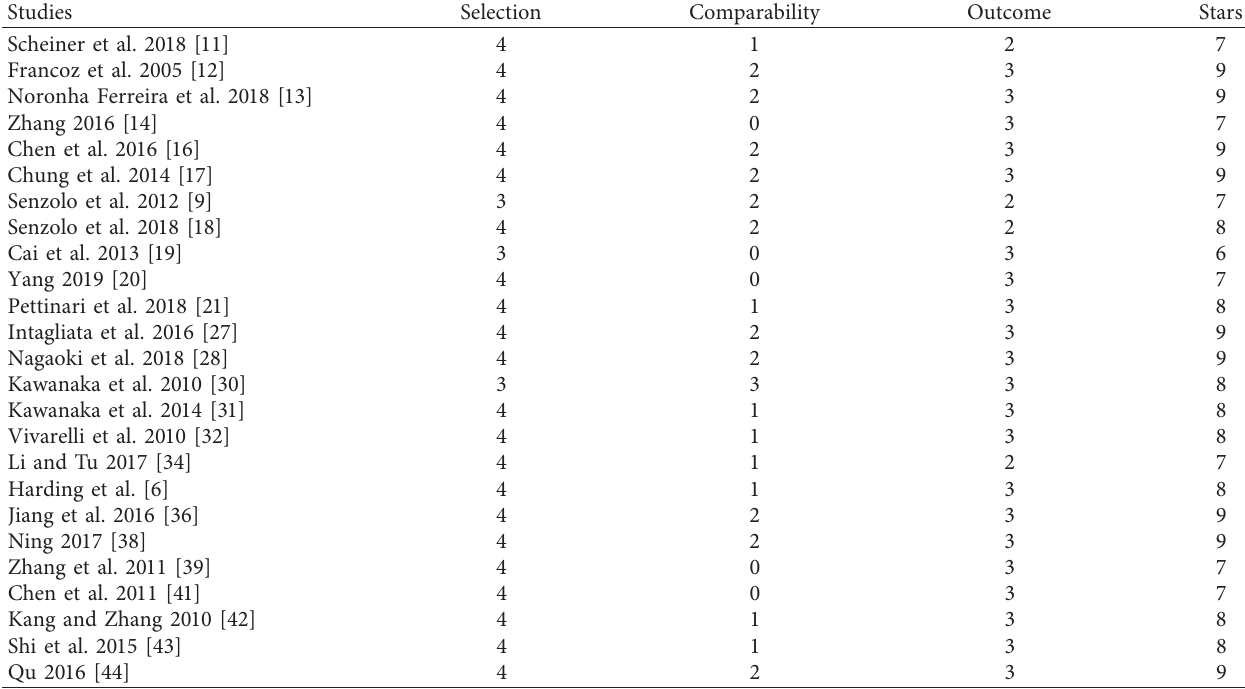
Table 2: The quality of studies with NOS